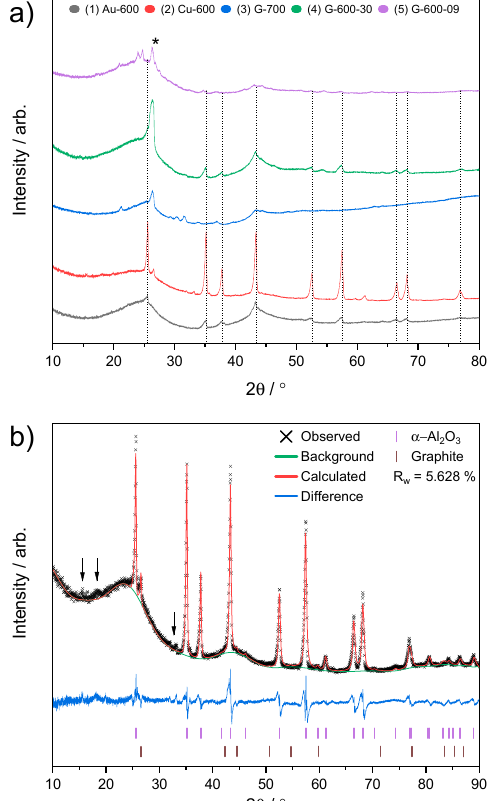
Figure 1. ( a ) Stacked plot of XRD patterns of all samples. Reflections of α -Al 2 O 3 are highlighted with dotted lines, while the asterisk (*) denotes the 2 θ ( ◦ ) position of the 002 reflection of graphite. ( b ) Rietveld analyses of Cu-600, highlighting the observed lab XRD data, the calculated background profile, calculated fit of the model to the data (with R w %), and the difference in the fit. Peak markers for phases of α -Al 2 O 3 and graphite are also shown. Black arrows indicate regions with impurities which were not indexed to any phases.